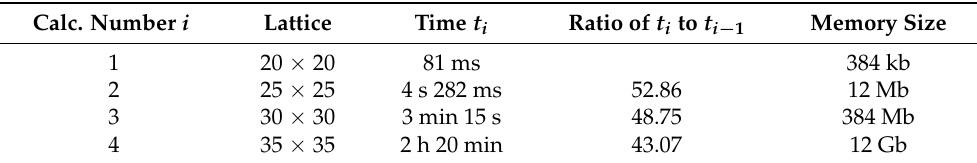
Table 1. Performance of the parallel algorithm for fbc spin lattice calculation for 20 × 20, 25 × 25, 30 × 30, 35 × 35 lattices on 64 threads.